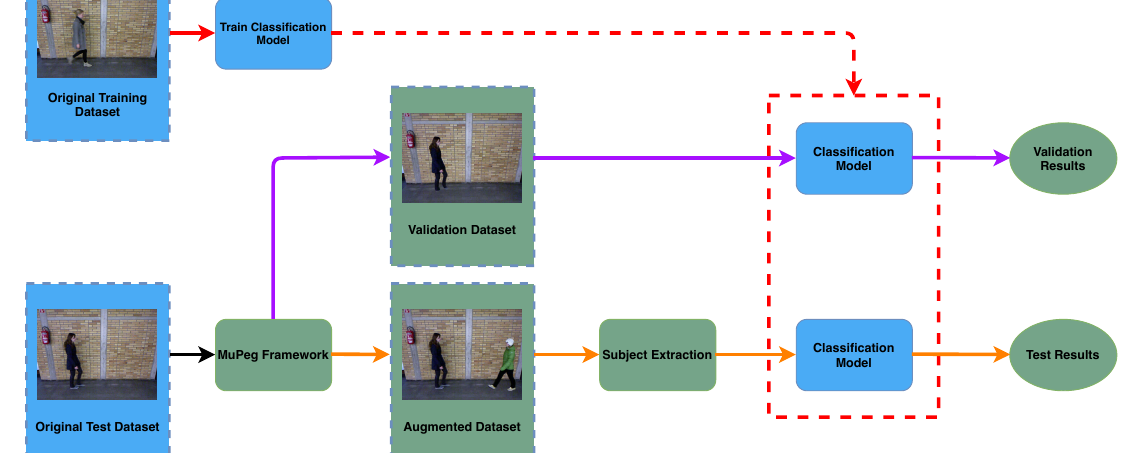
Figure 3. MuPeG use case. Outline of a typical use case of MuPeG framework. Blue elements identify training and test data belonging to the original dataset and the training of the Convolutional Neural Network (CNN) model based on the original training data. Green elements refer to procedures proposed in this paper. Red lines denotes the training process to obtain the Classification Model. Purple lines show the validation with just an aggregated subject. Orange lines represent the test with the augmented dataset including multiple subjects. (Best viewed in